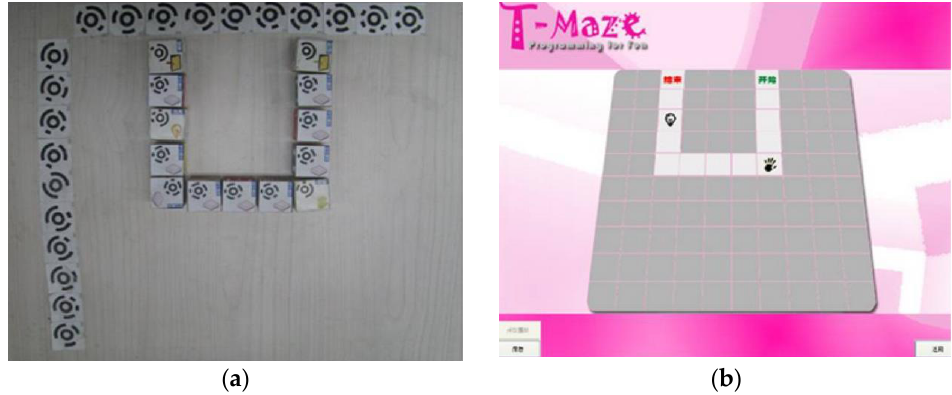
Figure 23. Creation of Maze Area by blocks ( a ), the user interface of Maze Creation ( b )